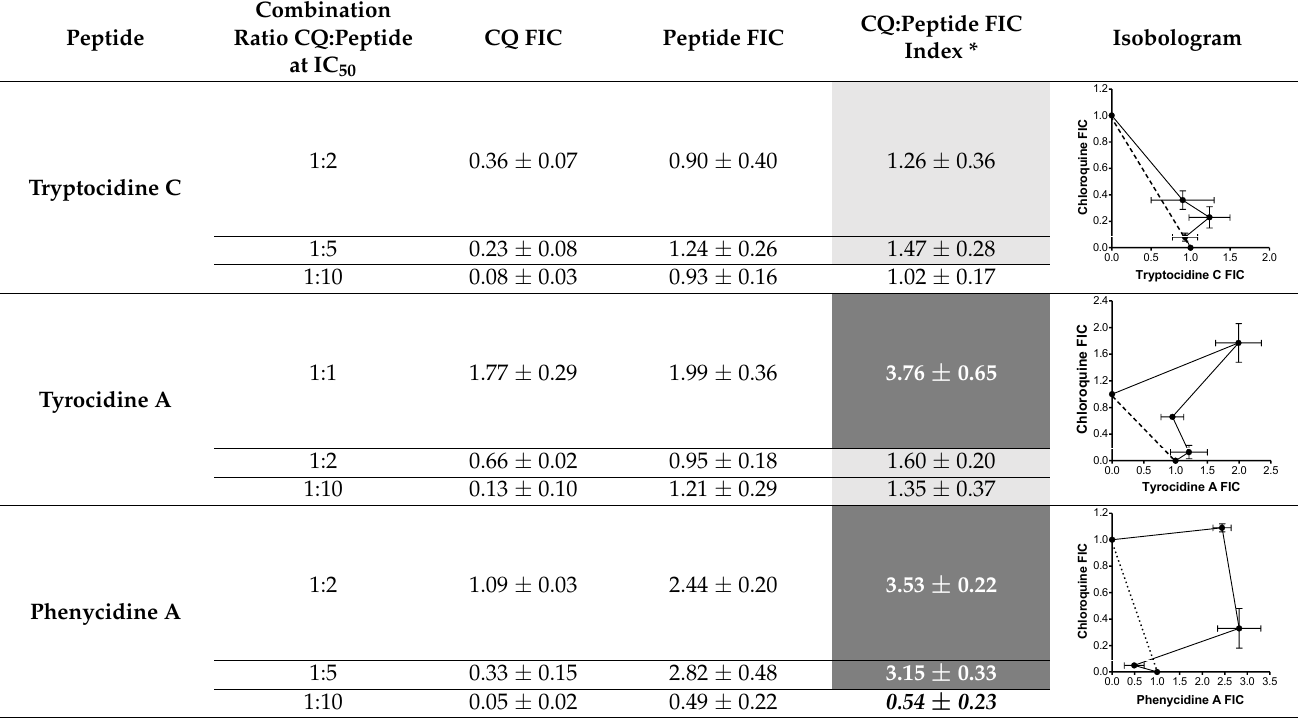
* Light-grey cell indicates slight antagonism, dark-grey cell indicates overt antagonism, white cell with normal font indicates sum of action, and white cell with bold italic font indicates synergism.